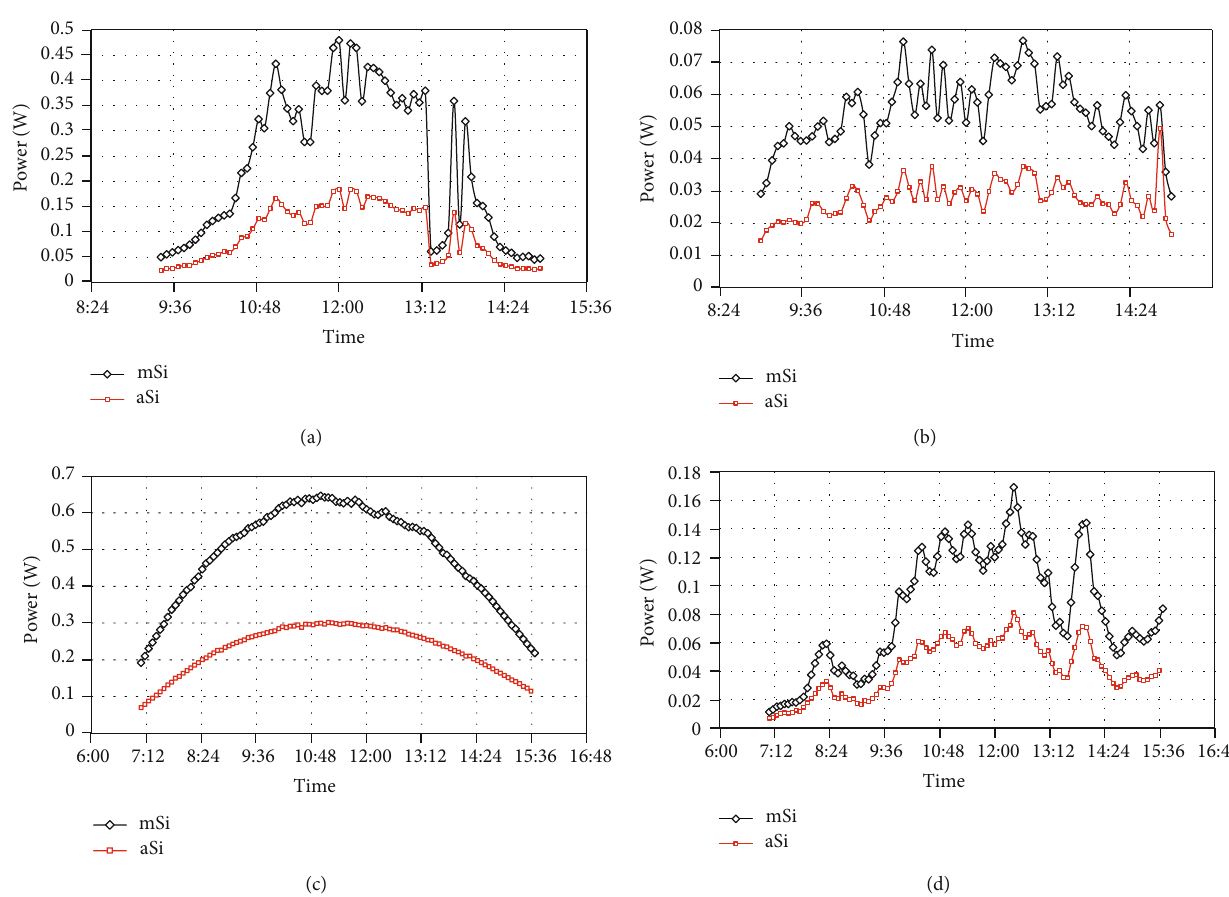
Figure 5: The maximum power generated by the two PV panels: (a) winter clear day, (b) winter cloudy day, (c) summer clear day, and (d) summer cloudy